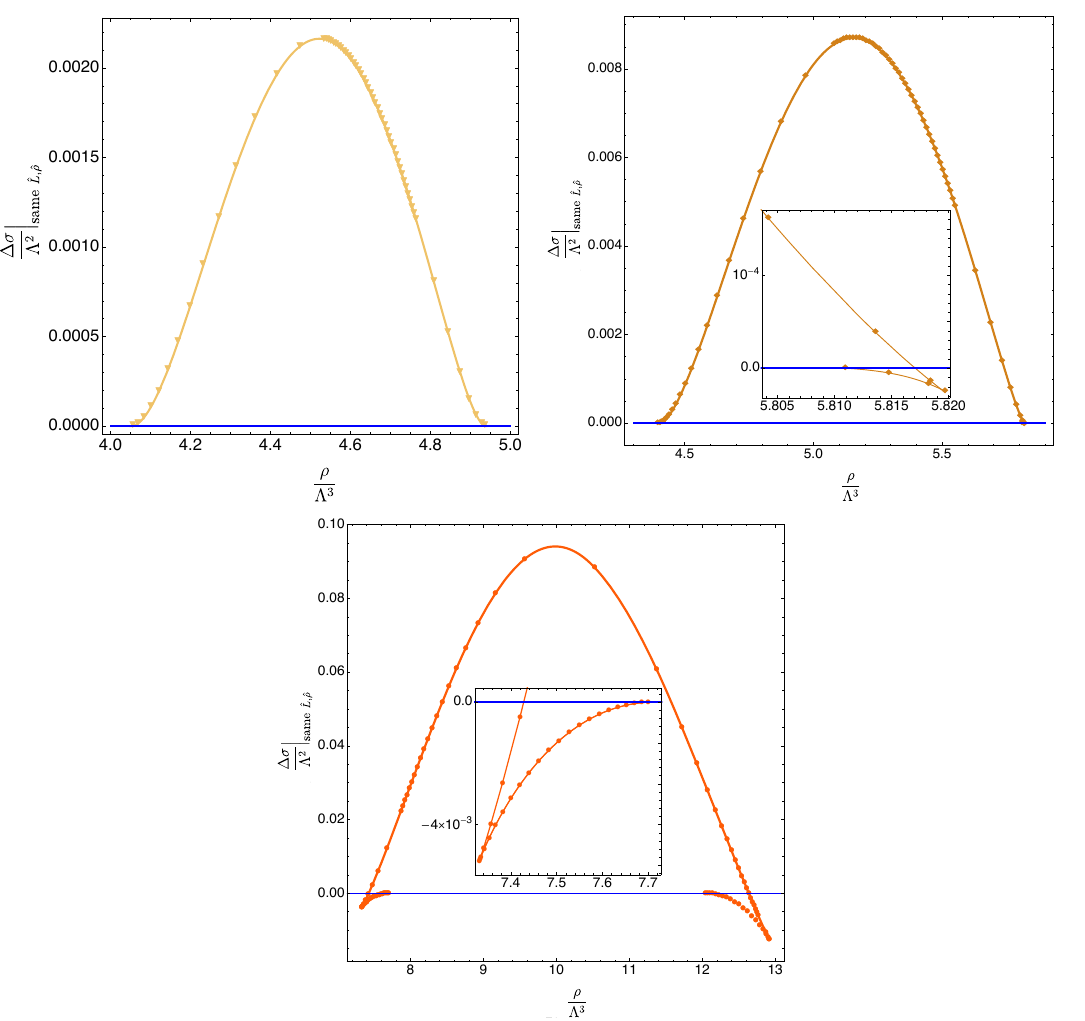
(cid:12) Figure 17 . Microcanonical phase diagram: Killing entropy density difference ∆ˆ σ between (cid:12) sameˆ L, ˆ ρ lumpy and uniform branes with the same (ˆ L, ˆ ρ ) as a function of the Killing energy density ˆ ρ for 3 families of lumpy branes that have constant ˆ L given by ˆ L ’ 5 . 299674 < ˆ L Σ (top-left), 1 ˆ L ’ 6 . 004224 which is in the range ˆ L ˆ L < ˆ L ˆ L ’ 11 . 501849 > ˆ L Σ 1 < Σ 2 (top-right) and Σ 2 (bottom). For reference, ˆ L Σ ’ 5 . 618133 and ˆ L Σ ’ 6 . 592316 . The three families are those with constant 1 2 { ˆ L H , ˆ L (cid:7) , ˆ L • } already displayed in figure 11; we use the same shape/colour coding for the markers (cid:12) execpt that here they are all solid. The horizontal blue line with ∆ˆ σ = 0 describes the (cid:12) sameˆ L, ˆ ρ uniform brane